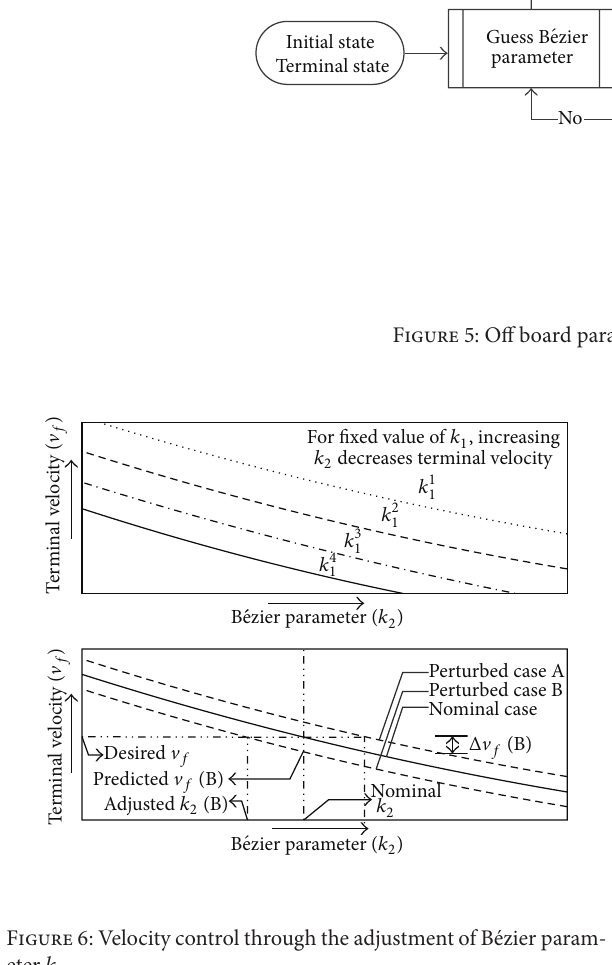
Figure 6: Velocity control through the adjustment of B´ezier param- eter 𝑘 2 .